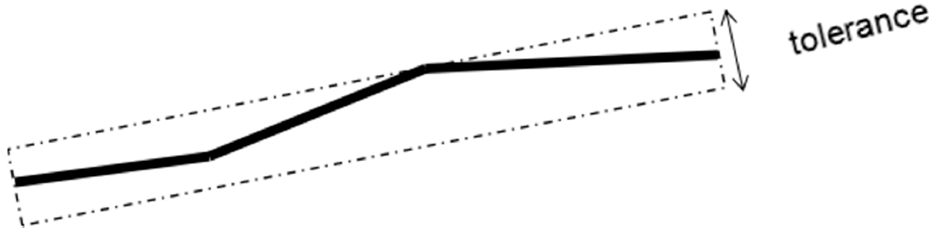
Figure 3. Vectorization process.